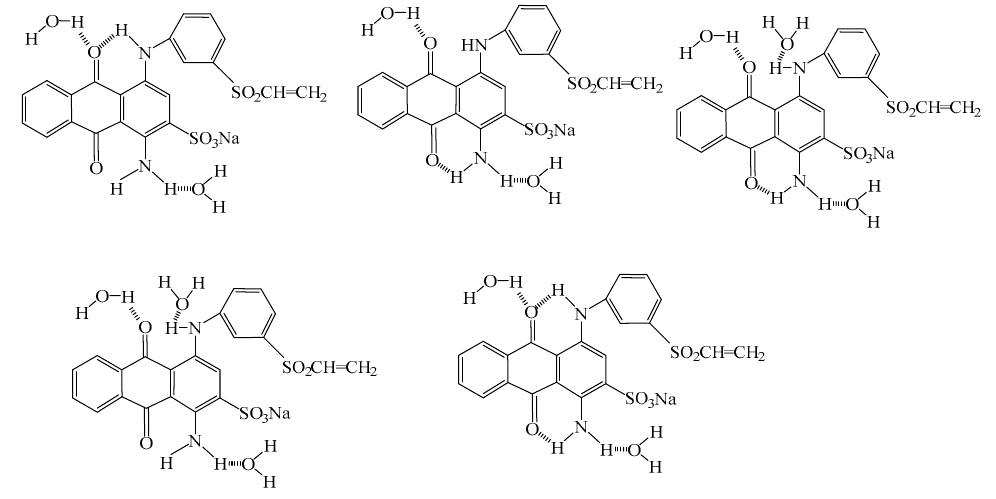
Figure 9. Possible structures of reactive blue 19 in aqueous solution.